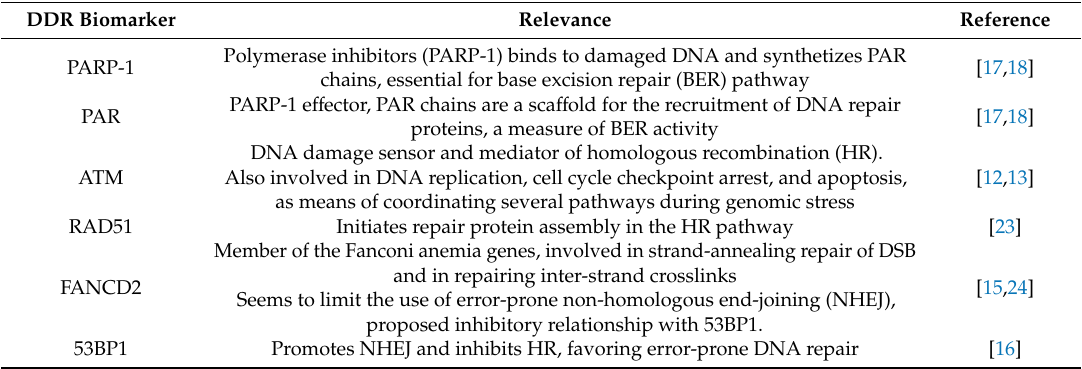
Table 1. DNA damage repair (DDR) biomarkers and their